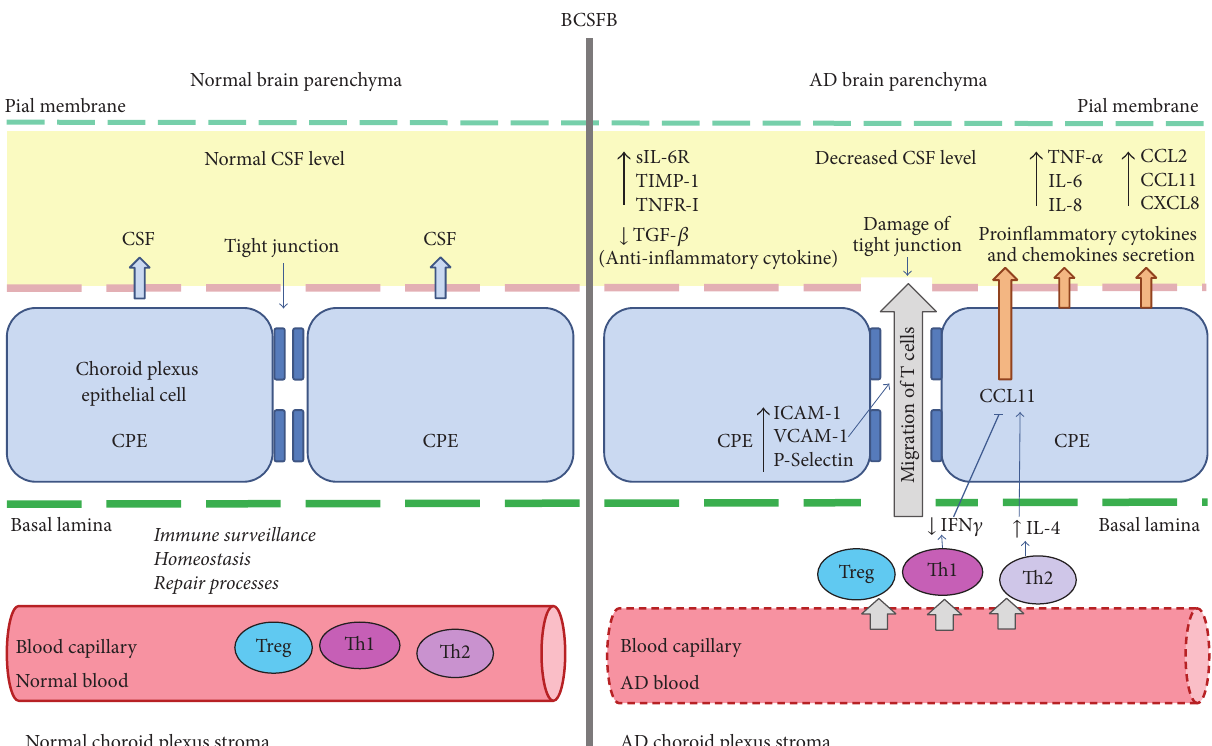
Figure 3: T lymphocytes infiltration and inflammatory mediators at the blood-cerebrospinal fluid barrier (BCSFB) in AD. The BCSFB is a selective barrier that restricts the passages of circulating immune cells from the stroma compartment into the brain parenchyma. In AD the BCSFB is impaired and T cells migrating through the BCSFB produce inflammatory mediators which are associated with the immune response to pathological conditions. At the BCSFB the chemokine CCL11 is produced in response to IL-4 secreted from Th2 cells and can be inhibited by IFN- 𝛾 secreted from Th1 cells. In the CSF in AD the increased levels of cytokines: TNF- 𝛼 , IL-6, IL-8, chemokines: CXCL8, CCL11, and CCL2, and cytokine receptors: sIL-6R, TIMP-1, and TNFR-I are observed. Moreover, enhanced expression of ICAM-1, VCAM-1, and P-selectin in the CPE leads to the damage of tight junctions and modulates immune cell migration to the CSF. Additional explanations can be found in the article text. Bold arrows indicate regulation of molecule levels [ ↑ , upregulation, ↓ , downregulation]. Blue arrows indicate affected